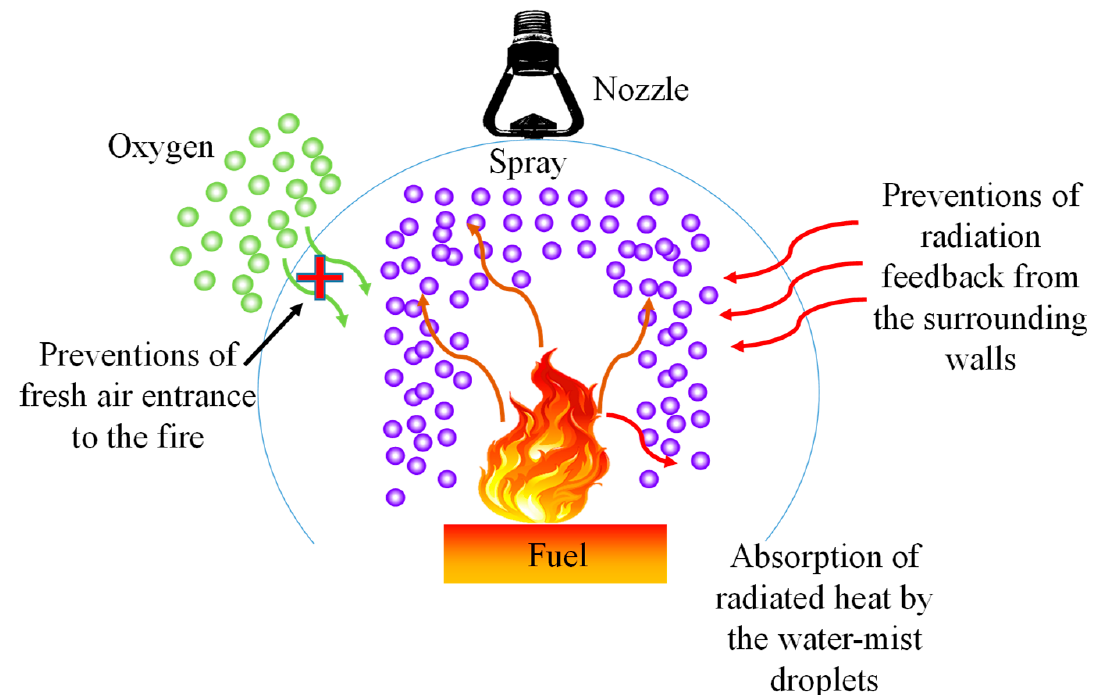
Figure 5. Attenuation of thermal radiation by a water mist system.